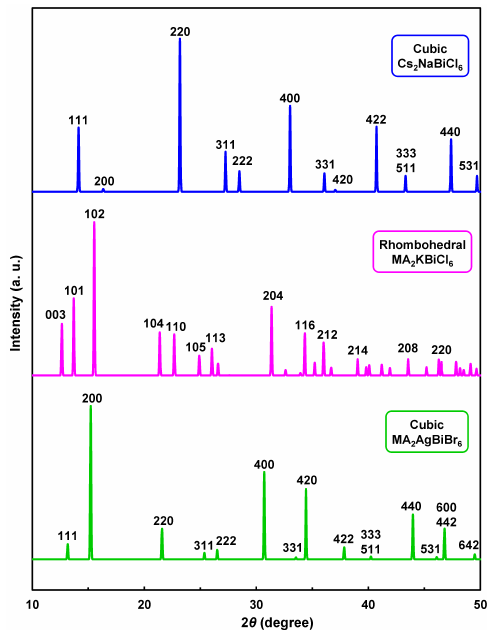
Figure 26: Calculated X-ray diffraction patterns of Cs 2 NaBiCl 6